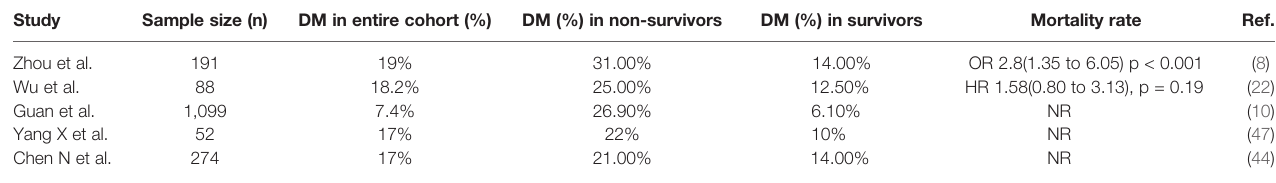
TABLE 3 | Prevalence of diabetes among non-survivor and survivor COVID-19 infected patients. Study